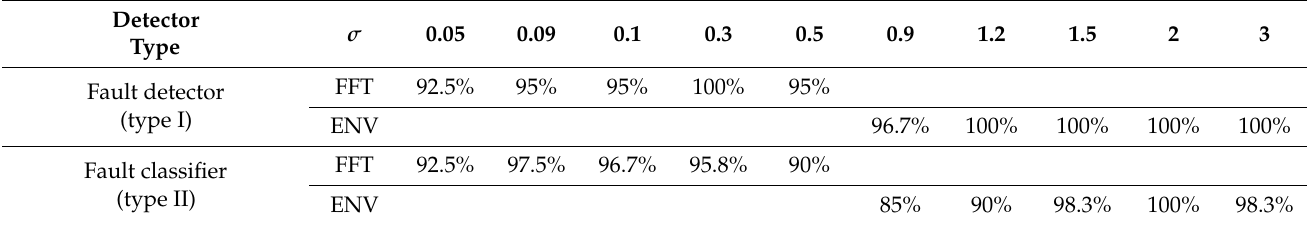
Table 5. RBF network efficiency for fault detector and classifier using FFT or ENV analyses for different spread, σ , coefficients.